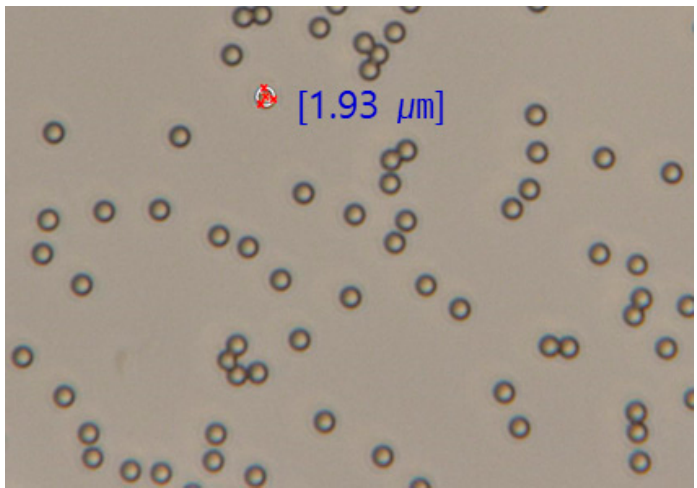
Figure 2. Microparticles (×3000).